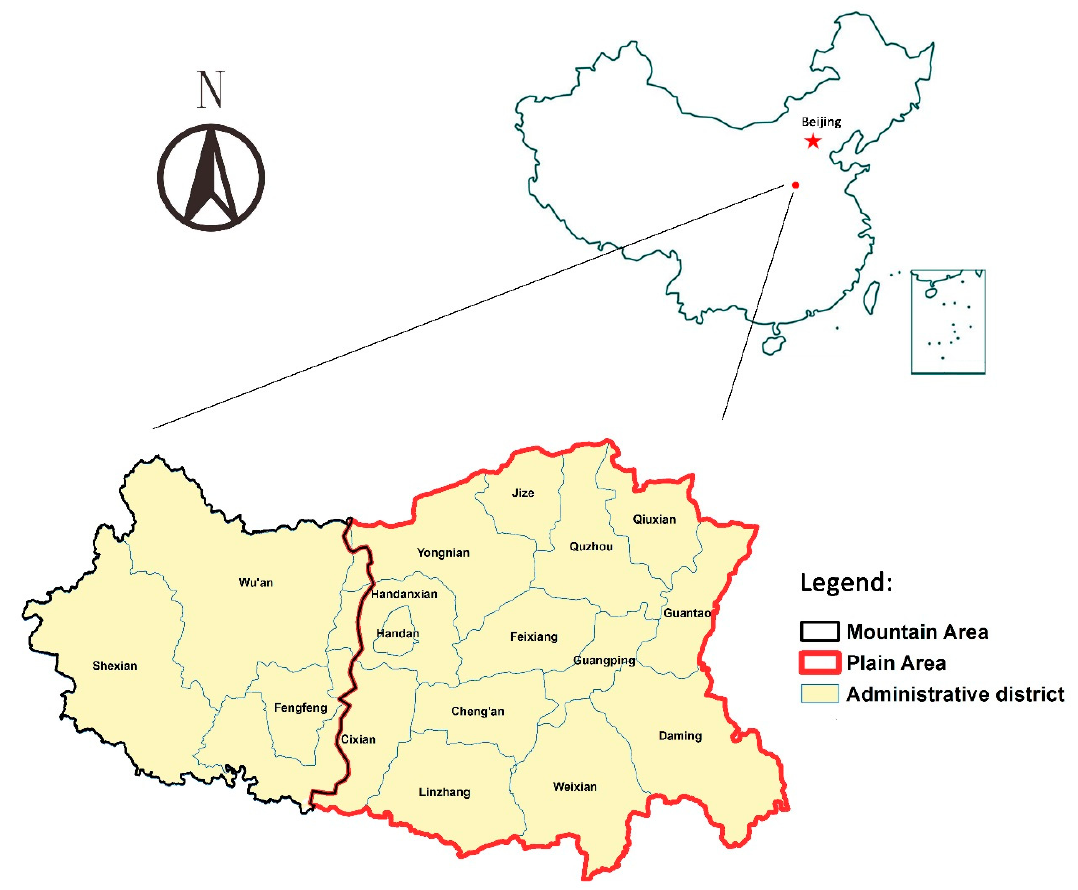
Figure 2. Location map of the study area.